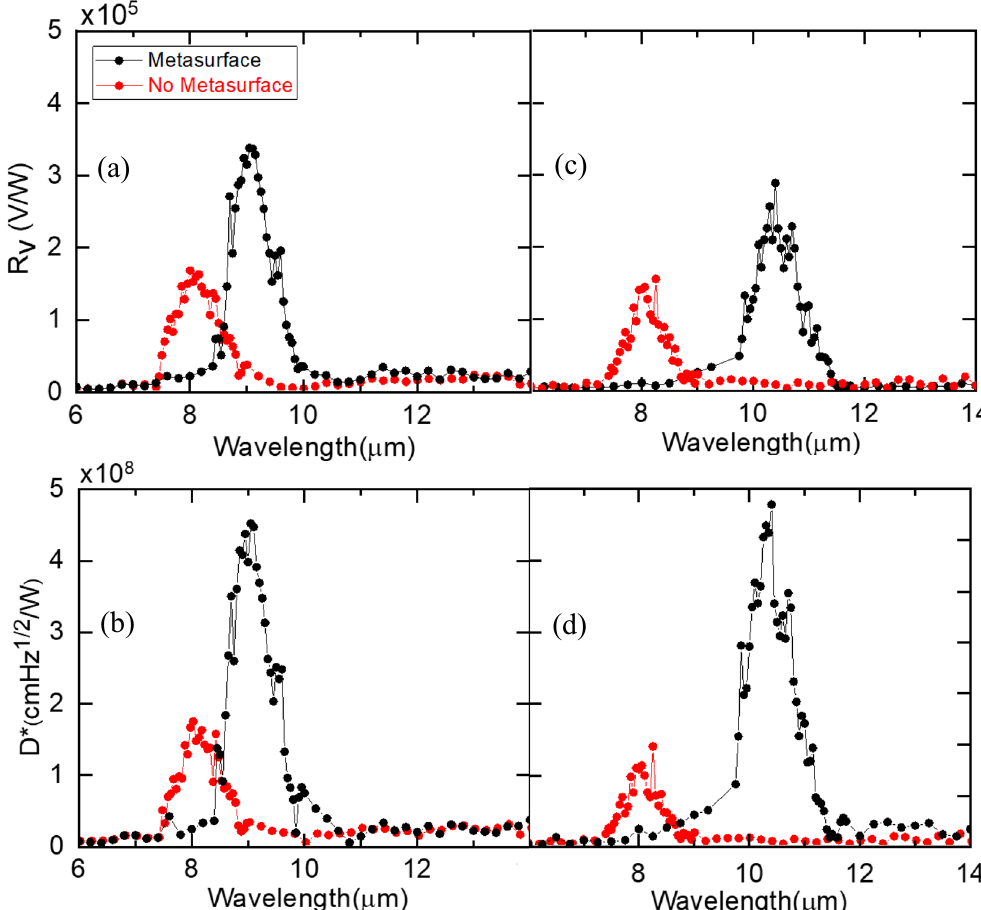
Figure 7. Measured responsivity and detectivity as a function of wavelength at 320 nA bias current for ( a , b ) detector with d = 1.11, p = 2.38 and (c, d) detector with d = 1.64, p =